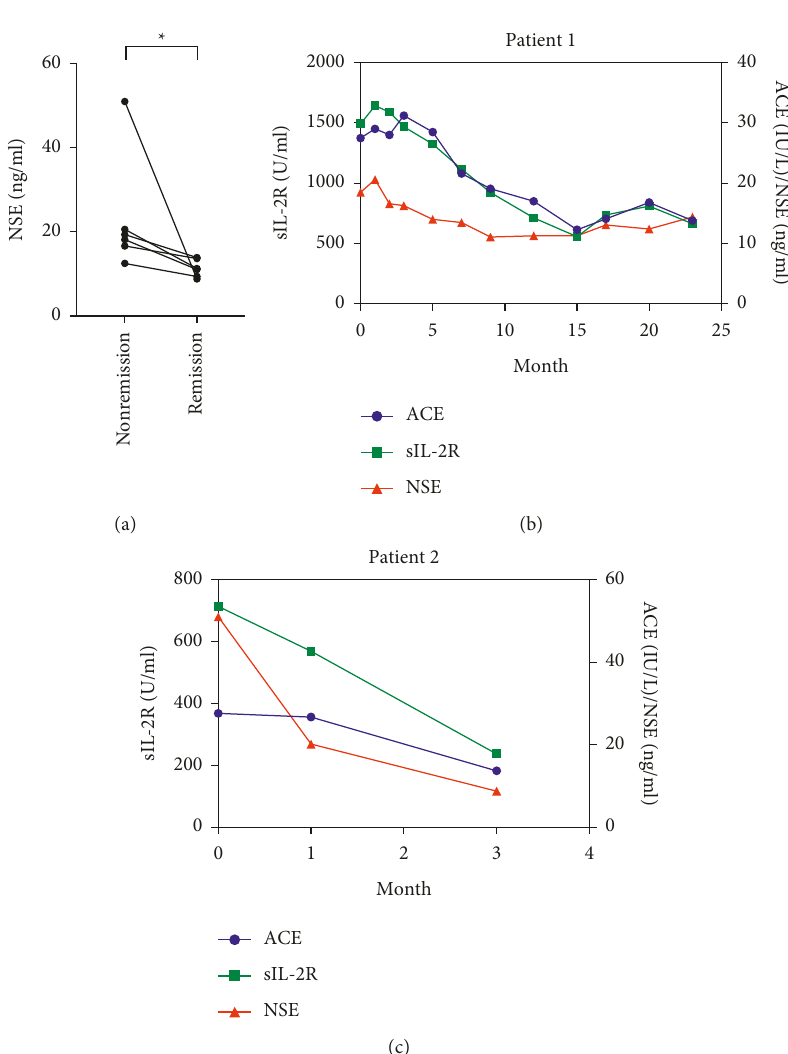
Figure 5: (a) Comparison of serum NSE levels between the remission and nonremission groups of 6 patients with sarcoidosis. Time courses of the laboratory data of ACE (IU/L), sIL-2R (U/ml), and NSE (ng/ml) in (b) Patient 1 and (c) Patient 2. ∗ P < 0 .